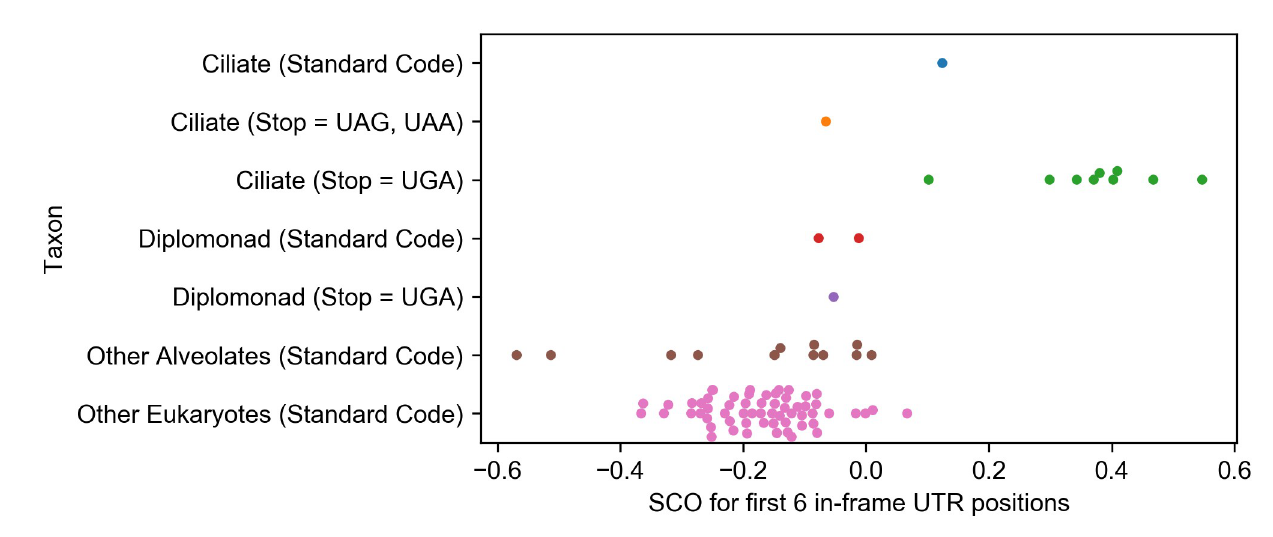
Fig 2. Plot of the combined SCO scores for the first six 3’ UTR positions across groups of species. Each point represents a genome, the y-axis separates the organisms based on their phylogeny and genetic code used.